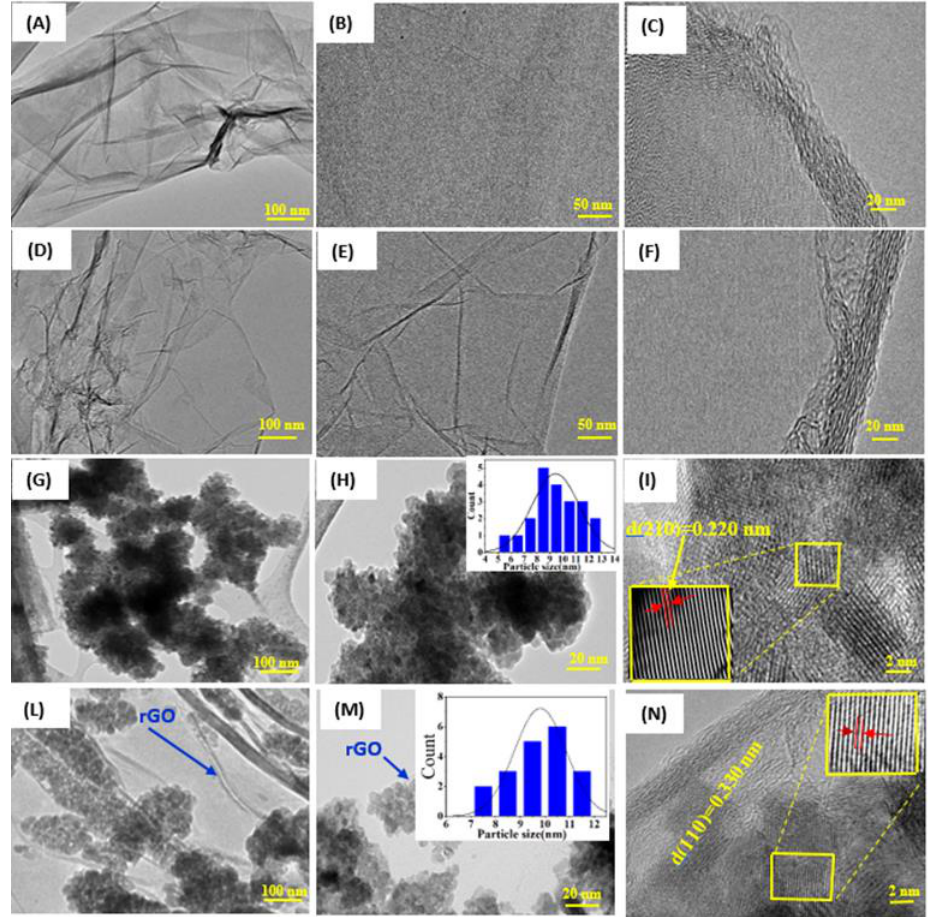
Figure 2. TEM characterization: TEM and HRTEM images of GO ( A – C ); rGO ( D – F ); SnO 2 NPs ( G – I ); SnO 2 -rGO NCs ( L – N ).